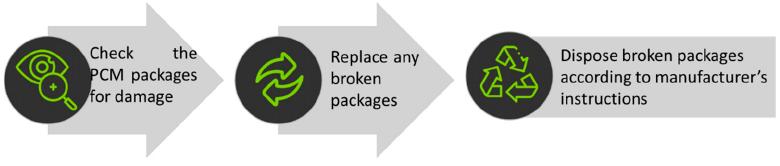
Figure 3. Inspection and disposable procedures for PCM packages.